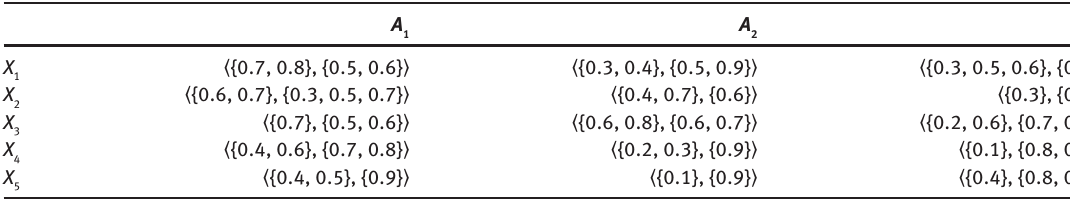
Table 3: Ordered Pythagorean Hesitant Fuzzy Decision Matrix.